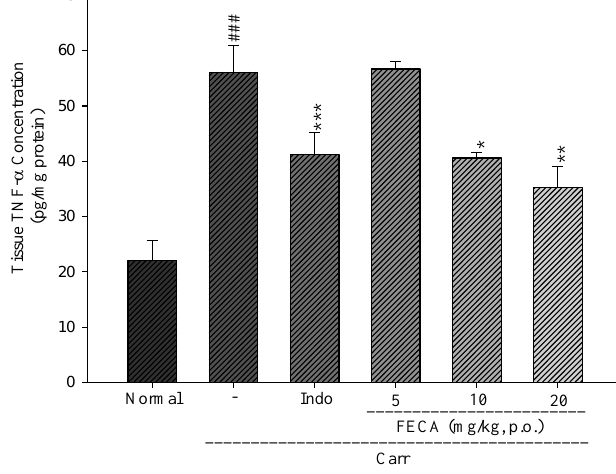
Figure 3. Effects of FECA and Indo on the tissue TNF-α concentration of edema paw in mice. Each value was represented as mean ± S.E.M. ### p < 0.001 as compared with the normal group; * p < 0.05; ** p < 0.01; *** p < 0.001 as compared to the λ-carrageenan (Carr.) group (one-way ANOVA followed by Scheffe’s multiple range test).